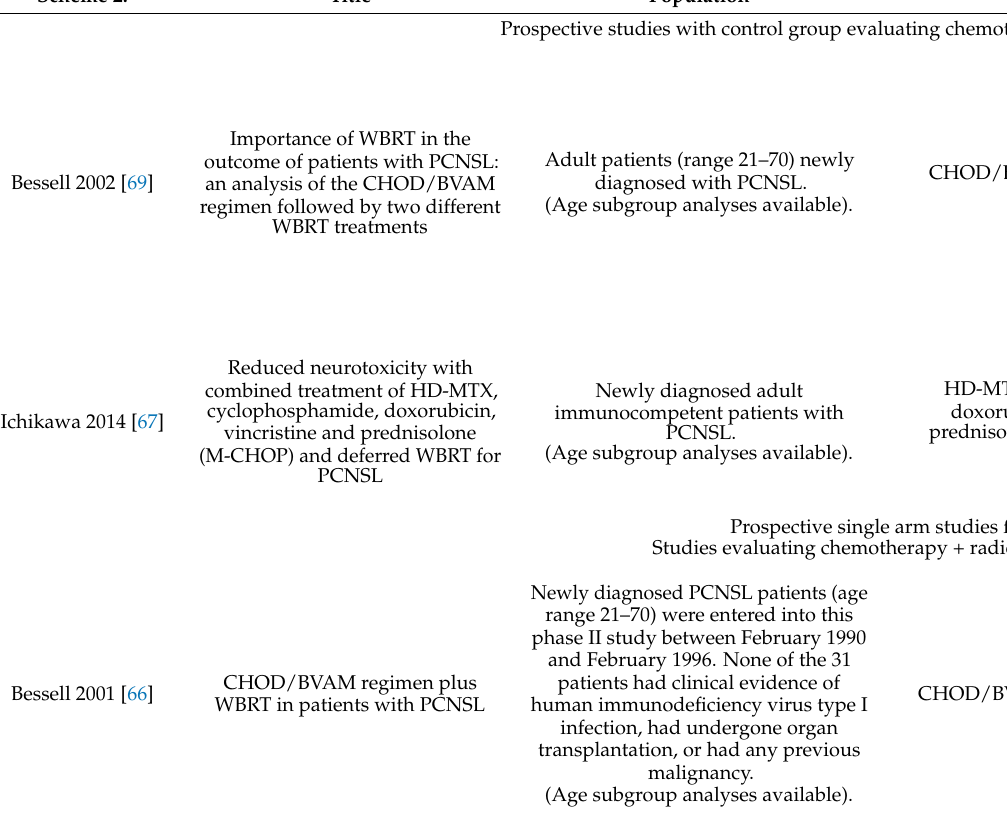
Table 3. Key characteristics of prospective, non-randomized studies including efficacy and toxicity outcomes. Scheme